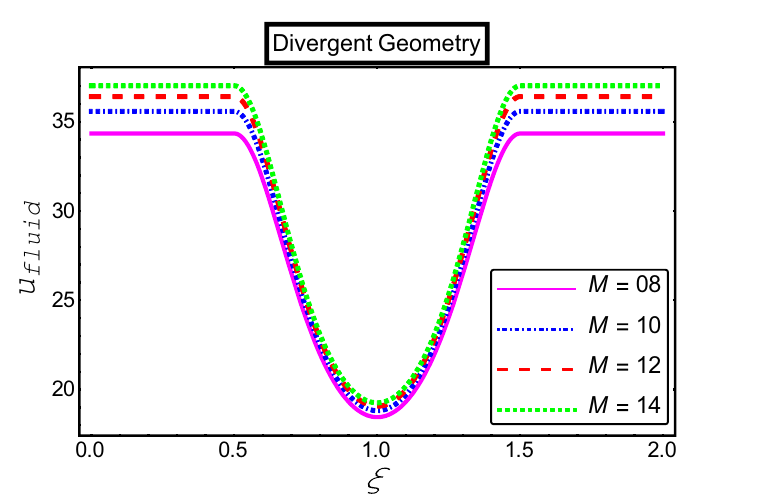
Figure 8. Impact of Hartmann numbers on fluid velocity.